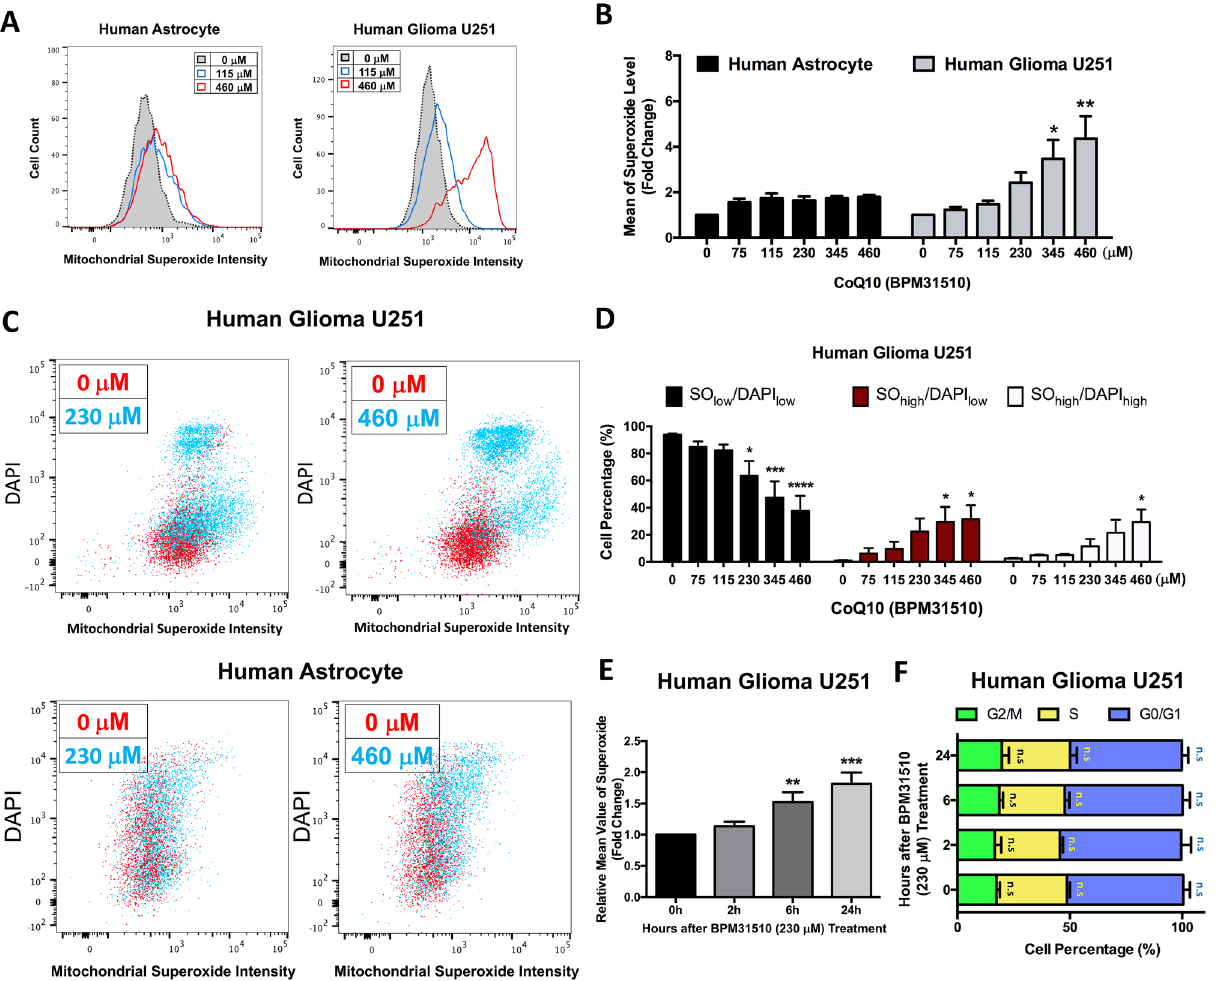
Figure 3. Differential redox vulnerabilities to ubidecarenone exposure between non-tumor and glioblastoma cells. ( A ) Flow cytometry analysis of O 2 − in HA or human U251 glioma cells treated with 0, 115, or 460 µM ubidecarenone. O 2 - intensity in each cell is demonstrated in the frequency histograms. ( B ) Quantification of mean O 2 − levels in HA and human U251 glioma cells. A modest increase in O 2 − is noted in HA in the presence of ubidecarenone, although this increase is not dose-dependent. In contrast, there is a fourfold O 2 − increase in rat C6 glioma cells in a dose-dependent manner. ( C ) Flow cytometry analysis (scatter plot) of O 2 − and DAPI in human U251 glioma and HA cells. Notably, there is minimal change in O 2 − intensity with increasing ubidecarenone dose in HA cells, while there is a marked increase in both O 2 − and DAPI in human U251 glioma cells after drug exposure. ( D ) Quantification of relative cell populations of O 2− low /DAPI low , O 2− high /DAPI low , and O 2− high /DAPI high in human U251 glioma cells demonstrating increasing numbers of high O 2- and DAPI labeled cells with increasing ubidecarenone dose. (E ) Flow cytometry analysis of O 2− for human U251 glioma cells treated with 230 µM ubidecarenone for 0, 2, 6, or 24 h. Relative mean values of O 2− were quantified and normalized to control at 0 h. ( F ) Cell cycle analysis by flow cytometry for human U251 glioma cells treated with 230 µM ubidecarenone for 0, 2, 6, or 24 h. The percentage of human U251 glioma cells in each cell cycle phase (G 0/1 , S or G 2 + M) was quantified. All data presented as Mean ± SEM. *P < 0.05, **P < 0.01, ***P < 0.001, ns = not significant, compared to control (0 µM) at the same cell cycle